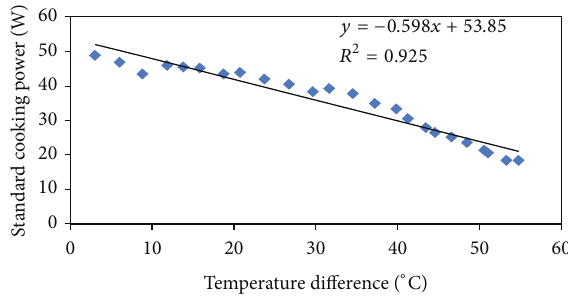
Figure 5: Standard cooking power plotted over temperature differ- ence